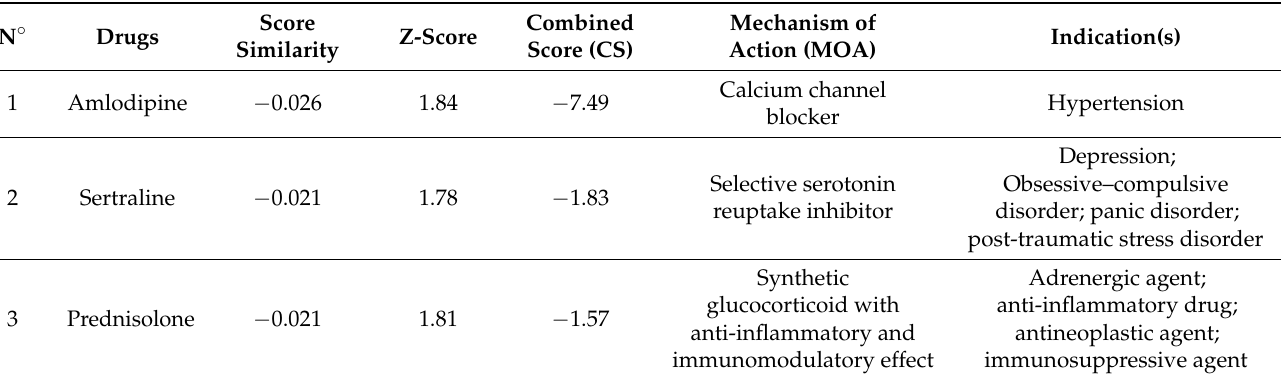
Table 4. Potential anti-ALS drugs identified by the L1000FWD analysis.